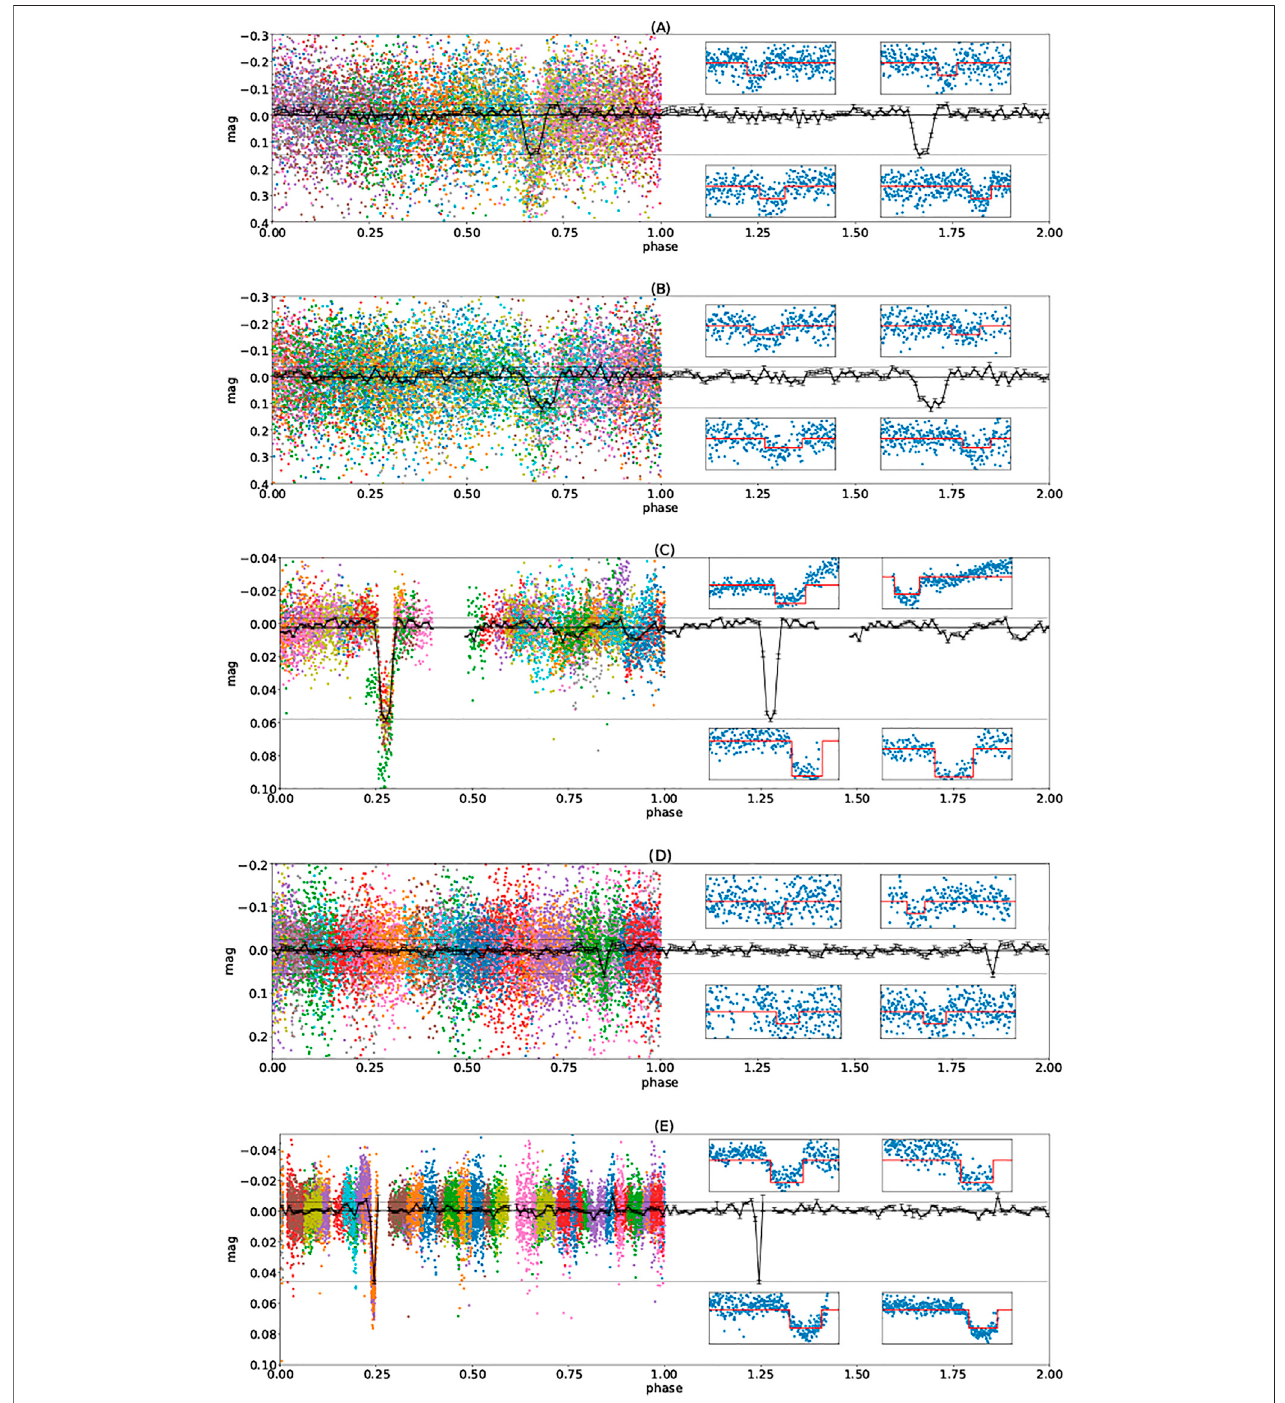
FIGURE7| Folded lightcurves of fi veobjects ofinterestand binned averaged curves (main panels). Pointsfrom different periods are shown indifferentcolors. The horizontal lines show the minimum, maximum, and median values. The four small panels show examples of individual transit events with the model found by the BLS method (see their parameters in Table 1